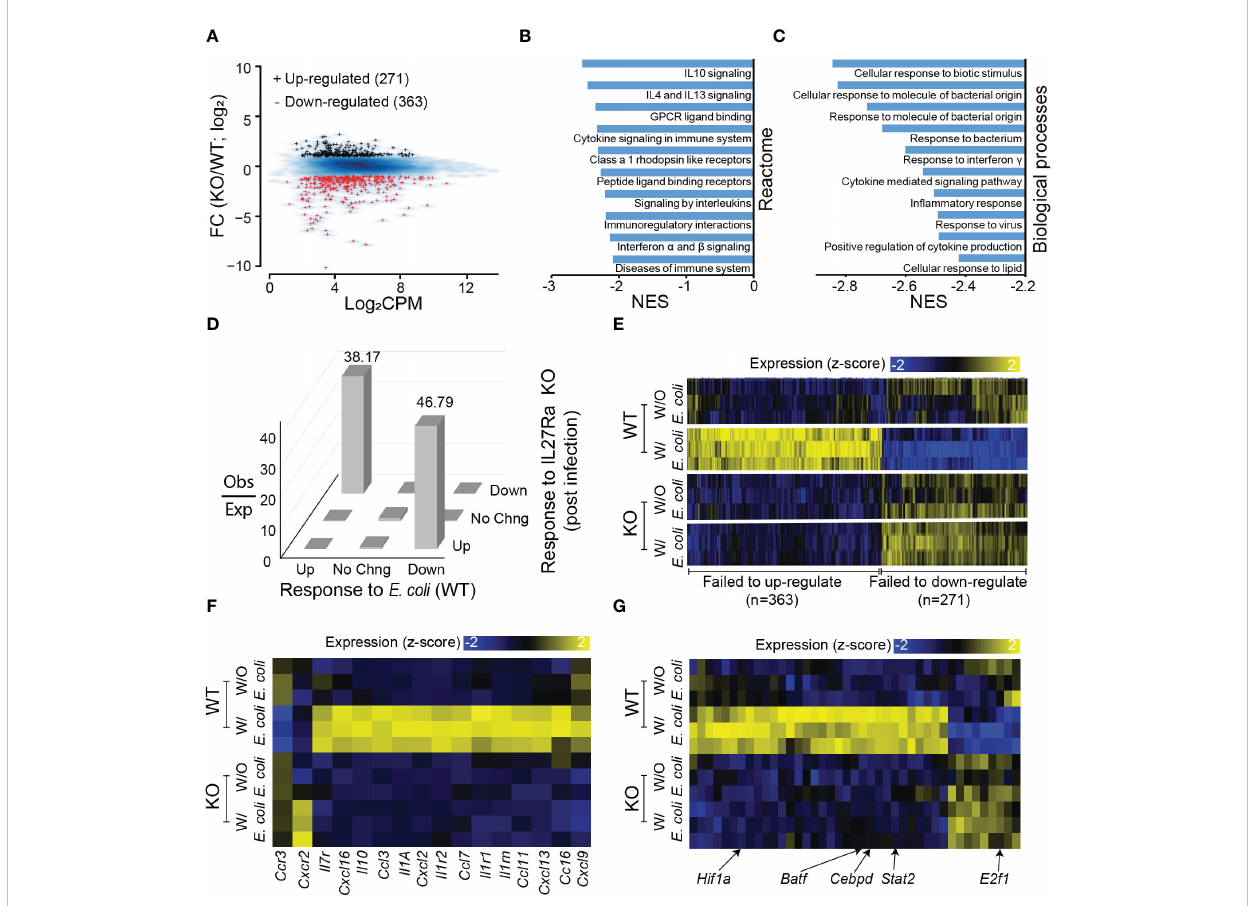
FIGURE 4 Transcriptional reprogramming in response to E. coli requires IL-27R a . (A) MA plot for genes differentially expressed in the spleen between IL-27R a - depleted (KO) and WT control following E. coli infection. Black +: genes upregulated by IL-27R a KO; red +: genes down-regulated by IL27R a KO. Blue smooth heat map: all expressed genes. (B) Top 10 gene sets for Reactome pathways that are upregulated post E. coli infection in the KO samples as predicted from GSEA (FDR q < 0.01). NES: normalized enrichment score. (C) Top 10 gene sets for gene ontologies in biological processes that are upregulated post E. coli infection in KO samples as predicted from GSEA (FDR q < 0.01). (D) Observed versus expected number of genes (z- axis), sorted based on expression changes induced by E. coli infection in control samples where IL-27R a is intact (x-axis) and expression changes induced by IL-27R a depletion in samples post E. coli infection (y-axis). Abbreviations on x-axis: Up = genes up-regulated by E. coli infection as compared to no-infection, both in WT cells; Down = genes down-regulated; No Chng = genes with no signi fi cant expression changes. Abbreviations on y-axis: Up = genes up-regulated by IL27Ra KO as compared to WT, both in cells post E. coli infection; Down = genes down- regulated; No Chng = genes with no signi fi cant expression changes. Abbreviations on z-axis: Obs = Observed number of genes; Exp = expected gene number of genes. (E) Heatmap visualization of expression values for genes that are differentially expressed between WT and KO samples in the presence or absence of E. coli infection. Each mouse is represented by a separate row. Genes are hierarchically clustered and manually annotated into two groups: failed to up-regulate or failed to down-regulate in gene expression during E. coli infection in the absence of IL-27R a . The expression values for each gene (column) are z-score transformed across samples (also applied to panes F, G ). (F) Similar to panel E but for a subset of genes annotated as chemokine receptors, interleukins, and chemokine ligands. (G) Similar to panel (E) but for a subset of genes annotated as transcription factors with representatives